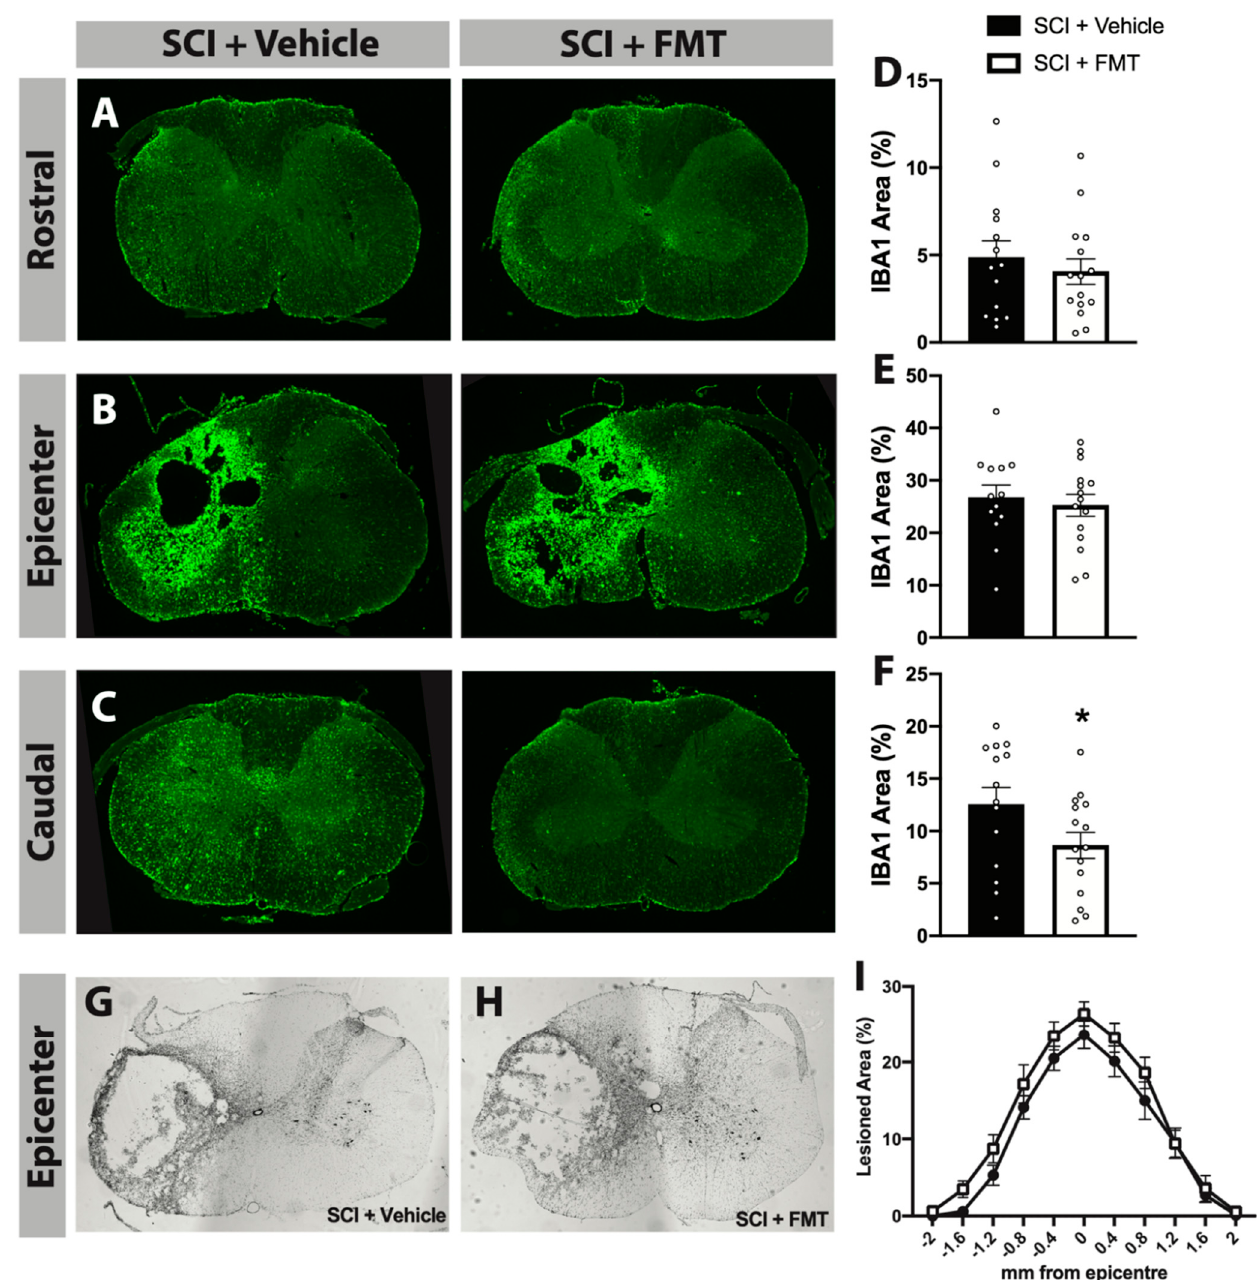
Figure 5. FMT from anxious donors reduced the area of IBA1+ cells caudal to the injury. Representative images of IBA1+ positive cells in the cervical spinal cord immediately rostral to the injury ( A ), at the injury epicenter ( B ) and immediately caudal to the injury ( C ). The percentage of IBA1+ area per spinal cord cross section rostral to, at and caudal to the lesion is quantified in ( D – F ), respectively. Immediately caudal to the injury, SCI + FMT rats displayed significantly reduced IBA1+ area compared to vehicle controls. Representative cross sections of the maximum injury site for SCI + Vehicle and SCI + FMT groups are shown in ( G , H ), respectively. ( I ) Quantification of the rostral (negative measurements) to caudal (positive measurements) extension of the lesion area was expressed as a percentage of lesioned tissue. * p < 0.05. Error bars represent standard error mean.